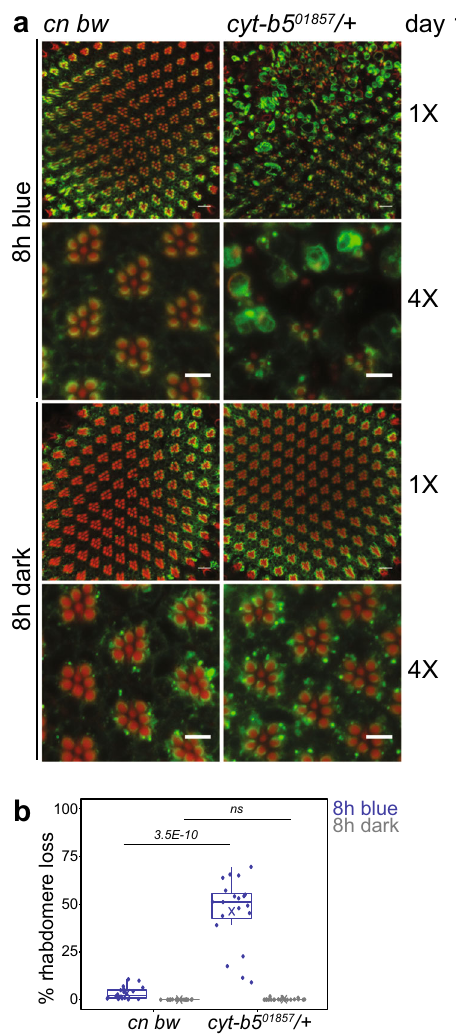
Fig. 5 Flies with reduced Cyt-b5 show enhanced blue light-induced retinal degeneration. a Confocal images of adult retinas from day 1 fl ies heterozygous for cytb5 01857 in the cn bw background vs. cn bw fl ies (control) exposed to 8 h blue light or dark control. b Box plots showing rhabdomere loss quanti fi ed using the confocal images. FDR, pairwise Wilcoxon Rank Sum Test between different genotypes under the same light treatment ( n = 4 light treatments; 5 animals/ experiment). ns not signi fi